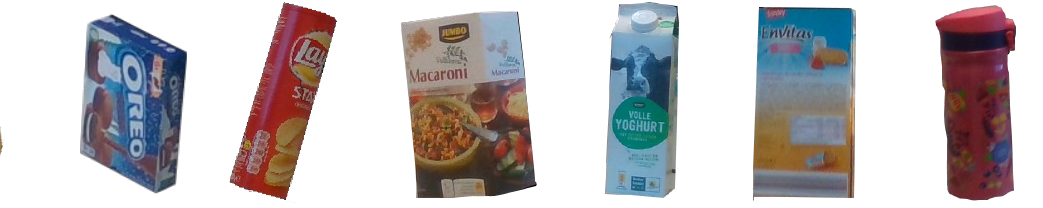
Figure 2. Daily used objects in our